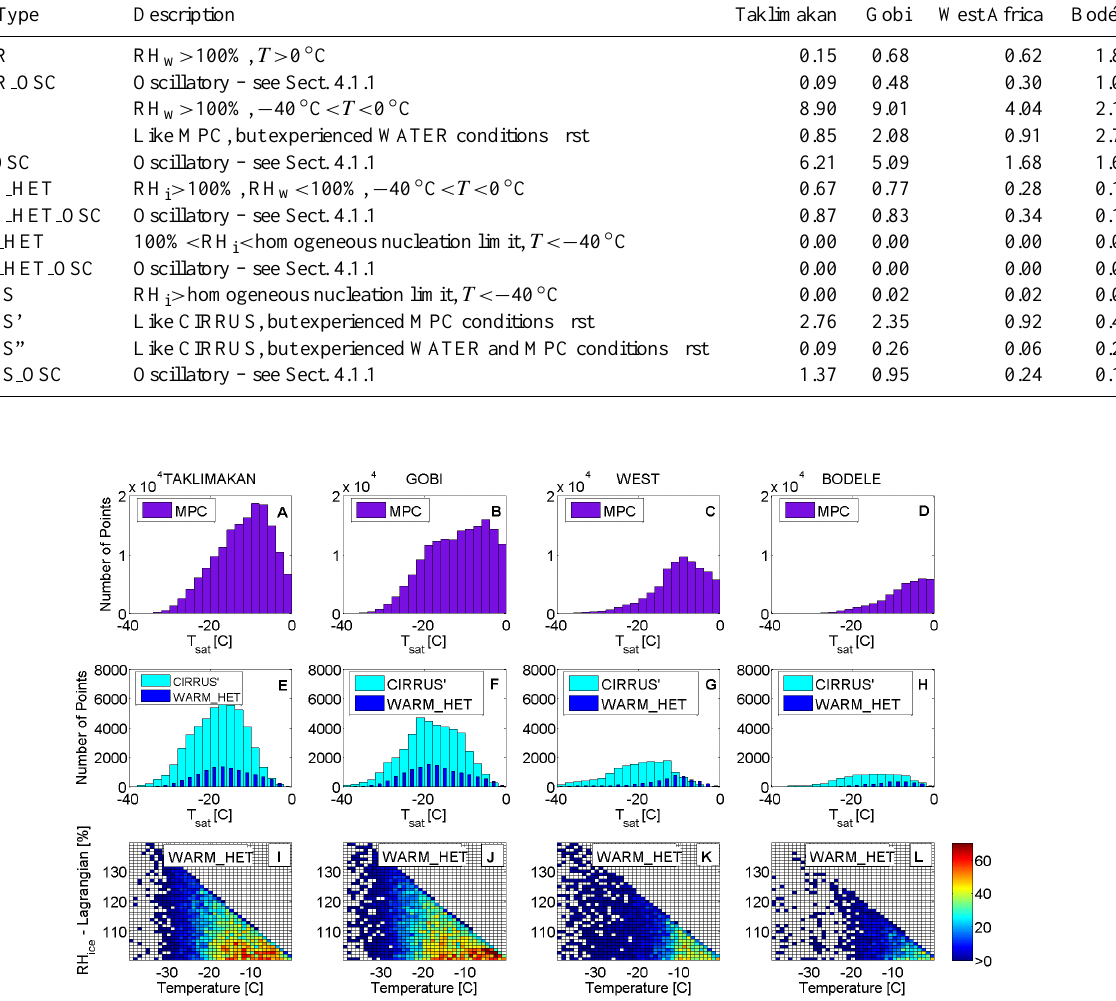
Fig. 7. Distribution of temperature at water saturation for trajectory points classified as MPC (A, B, C, D) and CIRRUS’ (E, F, G, H) clouds. Frequency of occurrence of WARM HET cloud points (I, J, K, L) in the RH i vs. T space, whose integral over RH i is shown in (E, F, G, H) using the T sat axis for brevity. Each geographic region is shown in a separate column, as